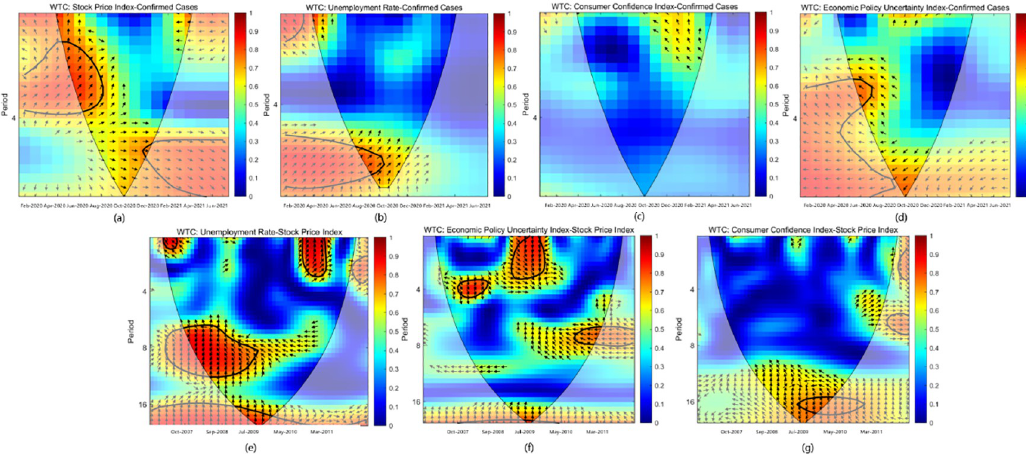
Fig 3. Wavelet coherence plots, pairwise estimates. Notes: The X-axis represents the time whereas, the Y-axis shows the period (in months).